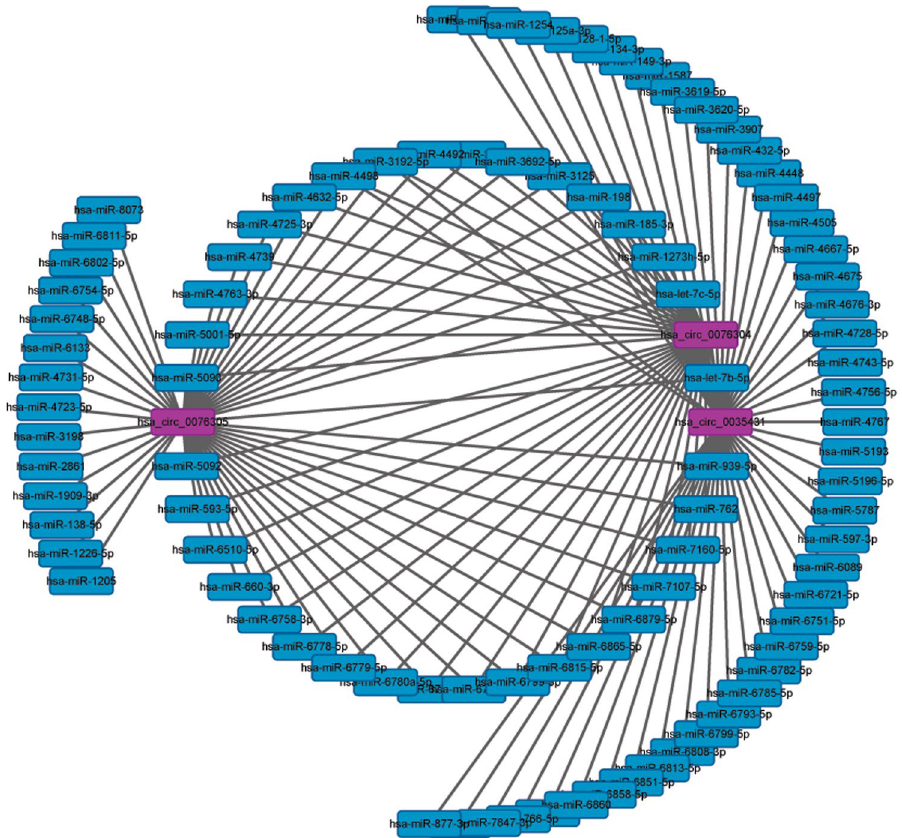
Figure 4. Represent circRNA-miRNA network. This network was based on the expression profile results and the related software. The 3 dysregulated circRNAs, hsa_circ_0076304, hsa_circ_0035431, and hsa_circ_0076305 (purple red nodes) having the highest magnitude of change, were predicted to be functionally connected with their targeted miRNAs in the